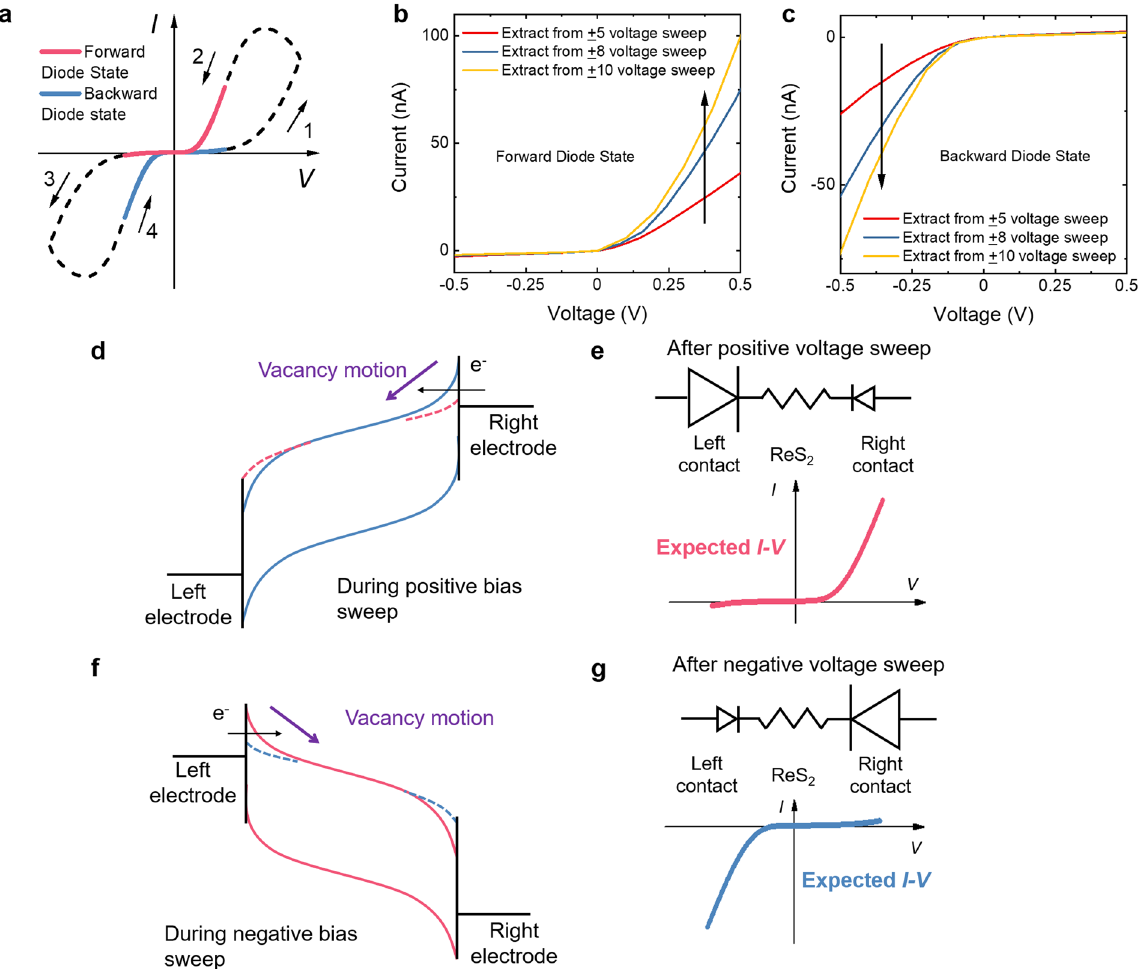
Fig. 3 Operation mechanism of ReS 2 memristors. a Schematic of I – V curve in linear scale. The black arrows indicate the voltage sweep order. The red and blue curves are two states at small voltage range after positive and negative voltage sweeps, respectively. b , c Forward and backward-diode state I – V curves extracted from different voltage sweep range. d Band diagram before and after positive voltage sweep. The upper blue curve shows the conduction band before voltage sweep, and the dashed red curves indicate the reduced SBH at right contact and increased SBH at left contact. e Qualitative device model after positive voltage sweep. The size of the Schottky diode symbols refer to the different SBH at contacts. The bottom schematic shows the expected I – V curves with small voltage range at forward diode state. f Band diagram before and after negative voltage sweep. The upper red curve shows the conduction band before voltage sweep, and the dashed blue curves indicate the reduced SBH at left contact and increased SBH at right contact. g Qualitative device model after negative voltage sweep. The bottom schematic shows the expected I – V curves at small voltage range at backward diode